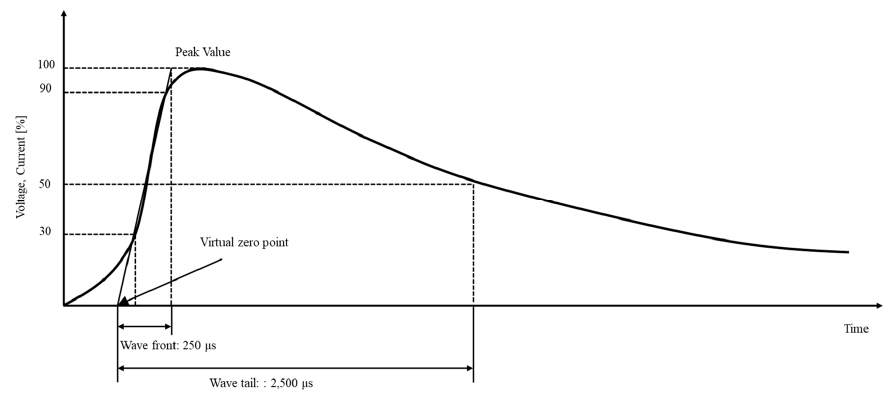
Figure 3. The waveform of standard switching impulse.